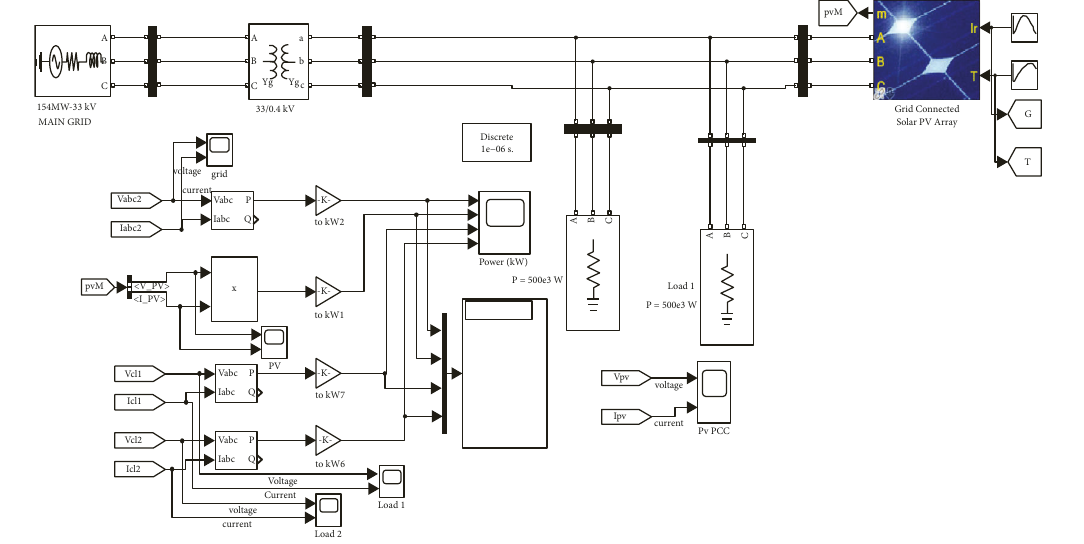
Figure 14: The main circuit